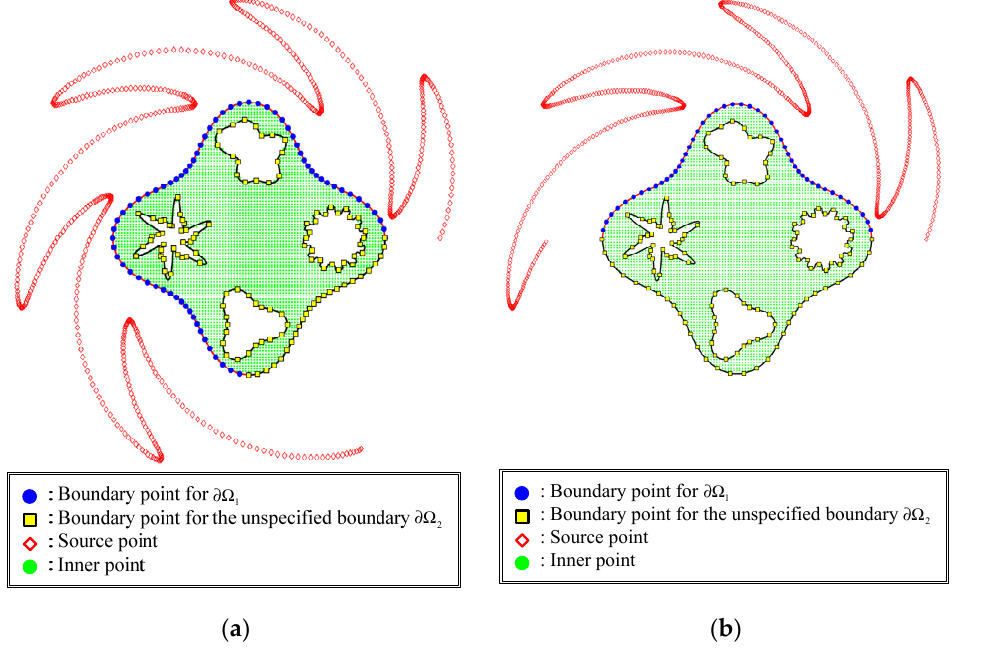
Figure 17. Location of the collocation points for Example 3: ( a ) case C and ( b ) case D.